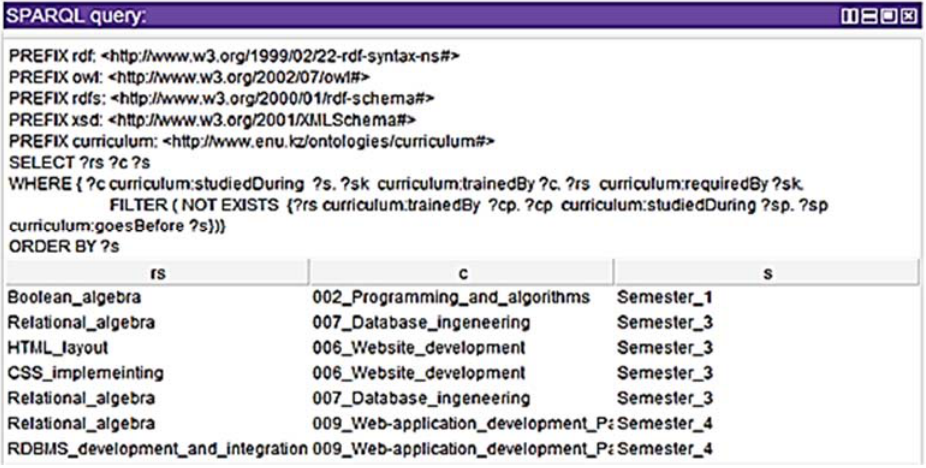
Figure 16. List of skills that cause inconsistency in the educational